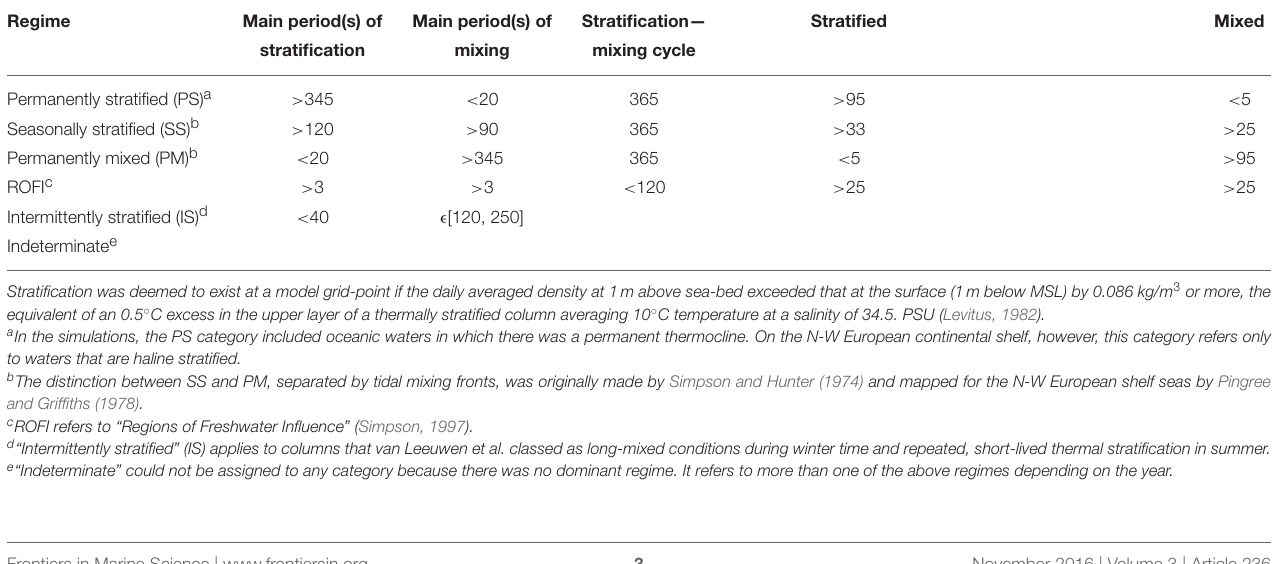
TABLE 1 | Criteria for ecohydrodynamic regimes and identification of stratification regimes; Definitions used by Van Leeuwen et al. (2015) to map stratification regimes in a 50-year hind-cast with GETM. Duration (days per year)